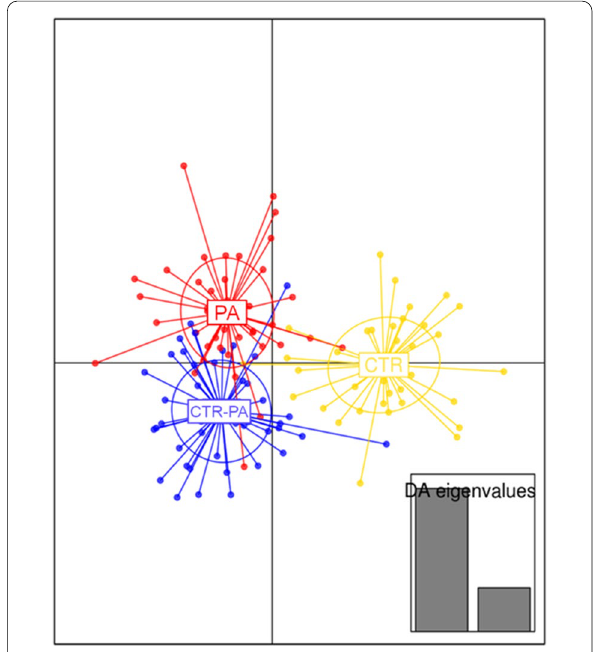
Fig. 6 Discriminant analysis of principal components (DAPC) showing the relationships among 35-day old piglets reared on sows fed different dietary treatments (CTR, CTR-PA and PA). Each dot represents the microbiota profile from one piglet, while each ellipse represents the groups. Discriminant analysis (DA) eigenvalues of the analysis are displayed inset